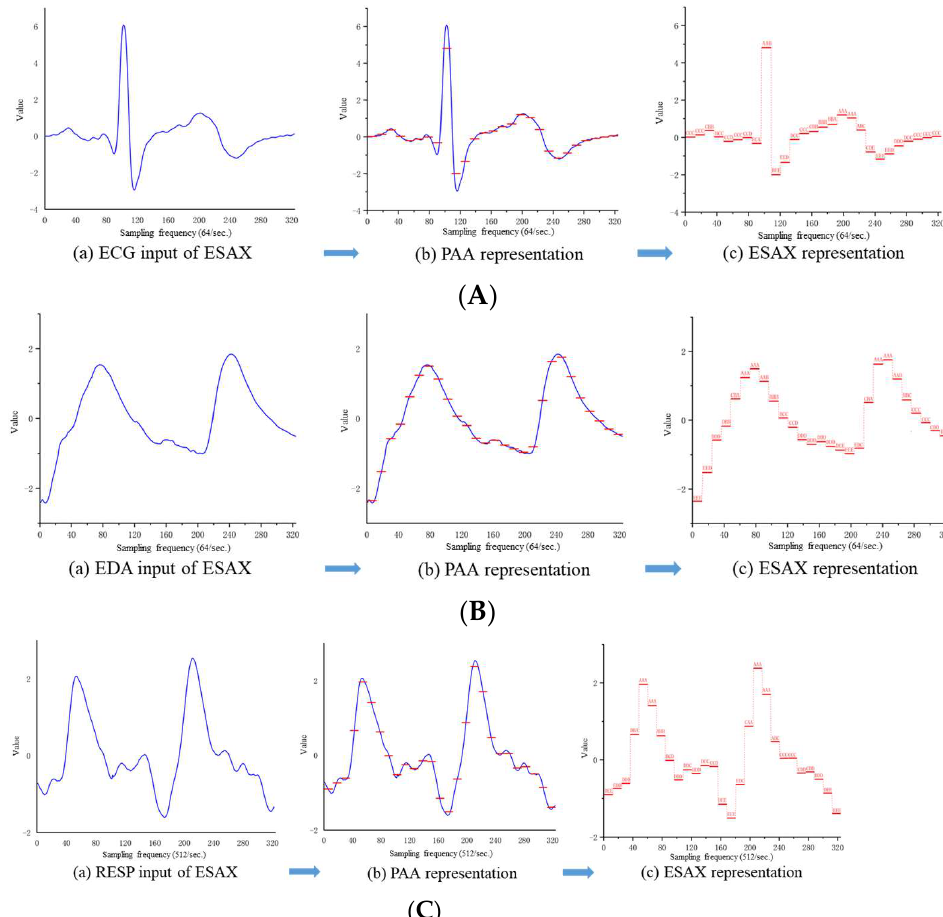
Figure 6. Discretization of physiological signal time series. ( A ) Electrocardiogram, ( B ) Electrodermal activity, ( C ) Respiration.